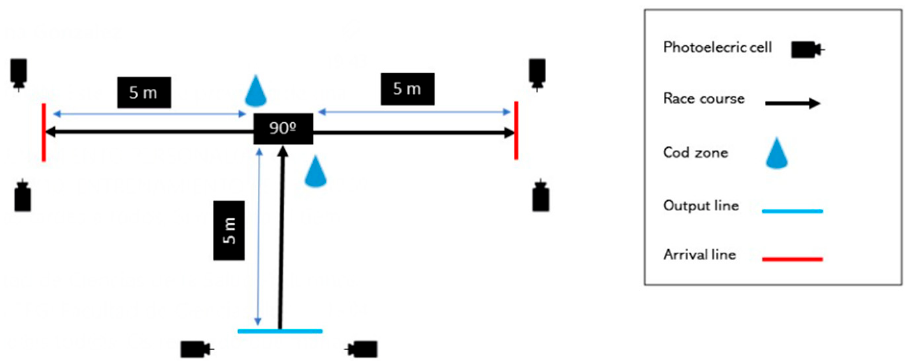
Figure 2. 90 ◦ COD Figure 2. 90° COD Test.